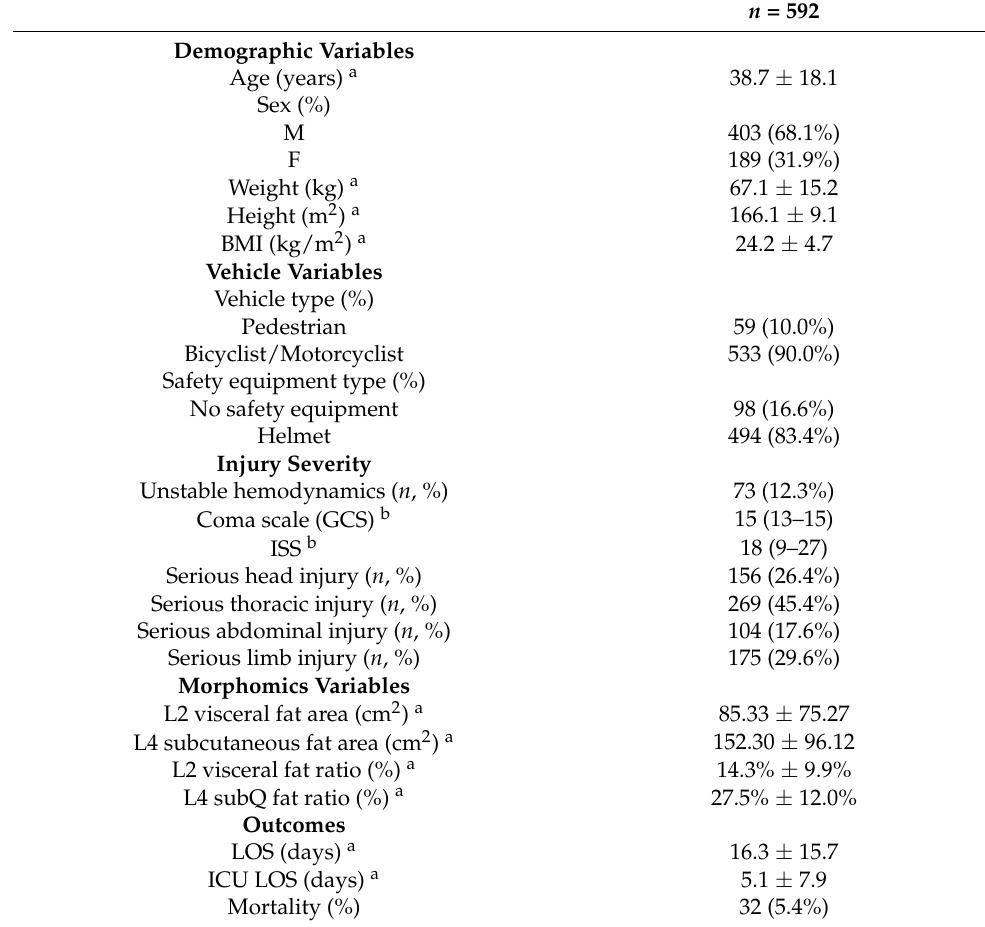
Table 1. Characteristics of enrolled vulnerable road